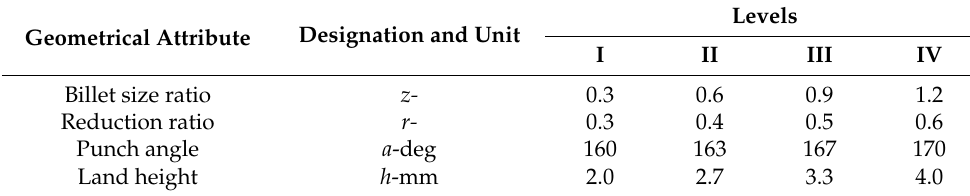
Table 2. Process variables and their